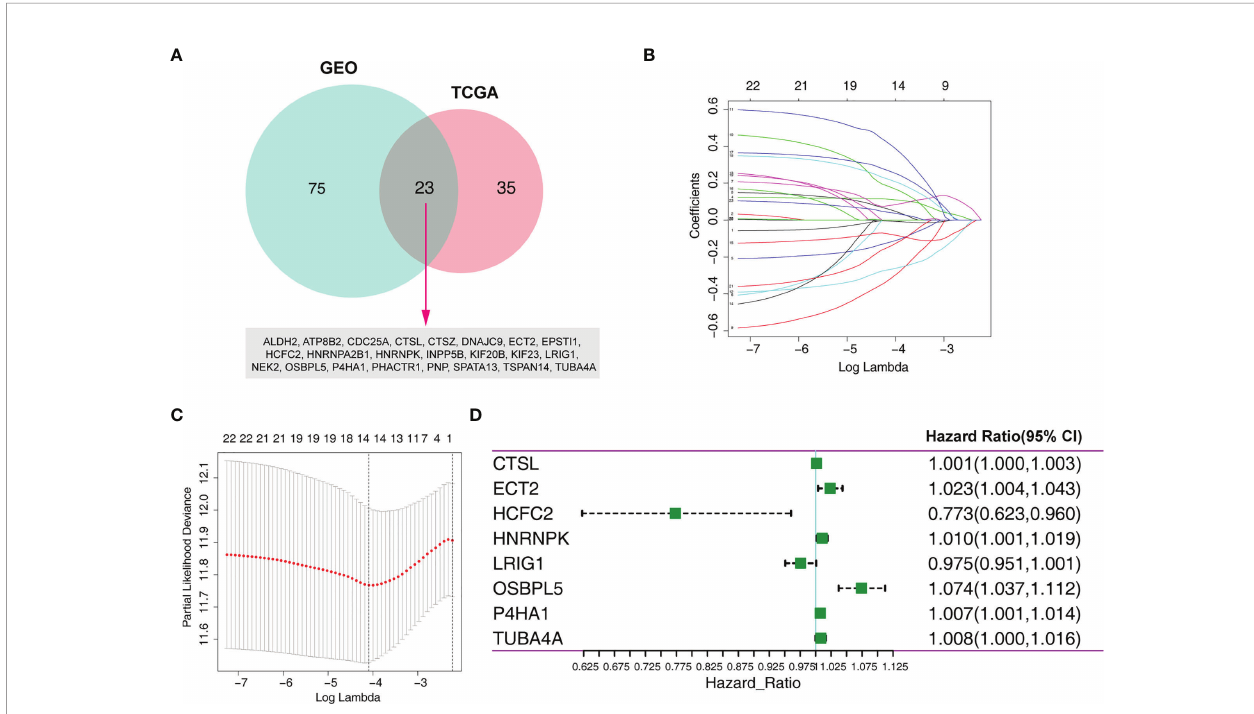
FIGURE 1 | Identi fi cation of an MRG-based prognosis signature. (A) Twenty-three overlapping overall survival-related MRGs from TCGA and GEO databases were obtained following univariate Cox regression analysis. (B) Lasso coef fi cient pro fi les of the 23 prognosis-associated MRGs from the training set. (C) Partial likelihood deviance of variables revealed by the Lasso regression model. (D) Forest plot of multivariate Cox regression